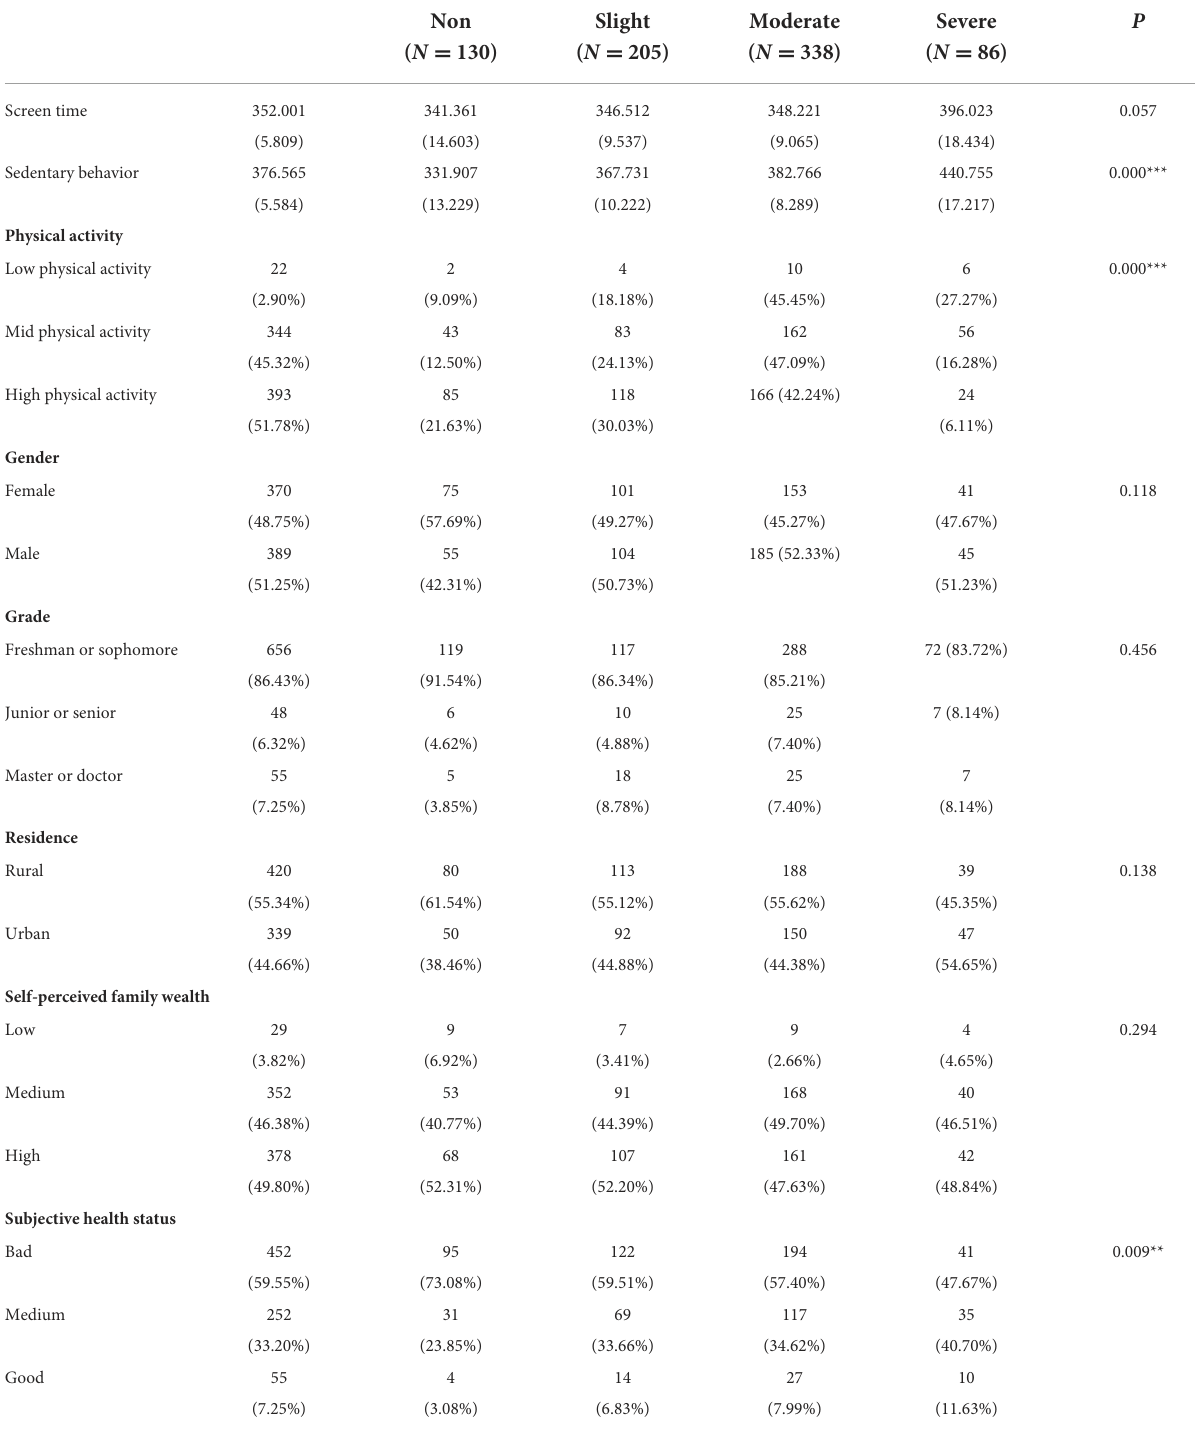
TABLE 1 Data description and correlation test for all